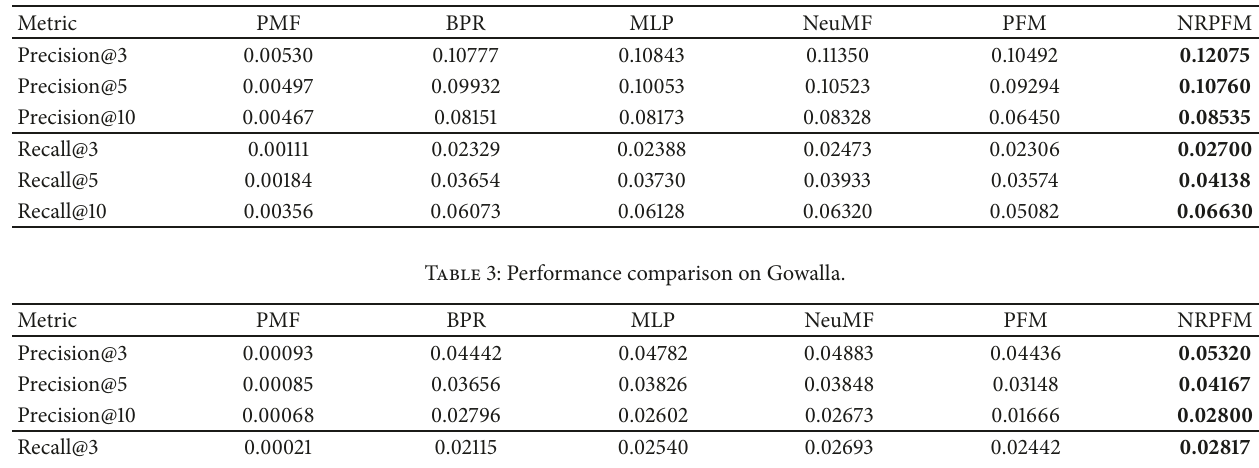
Table 2: Performance comparison on Foursquare.